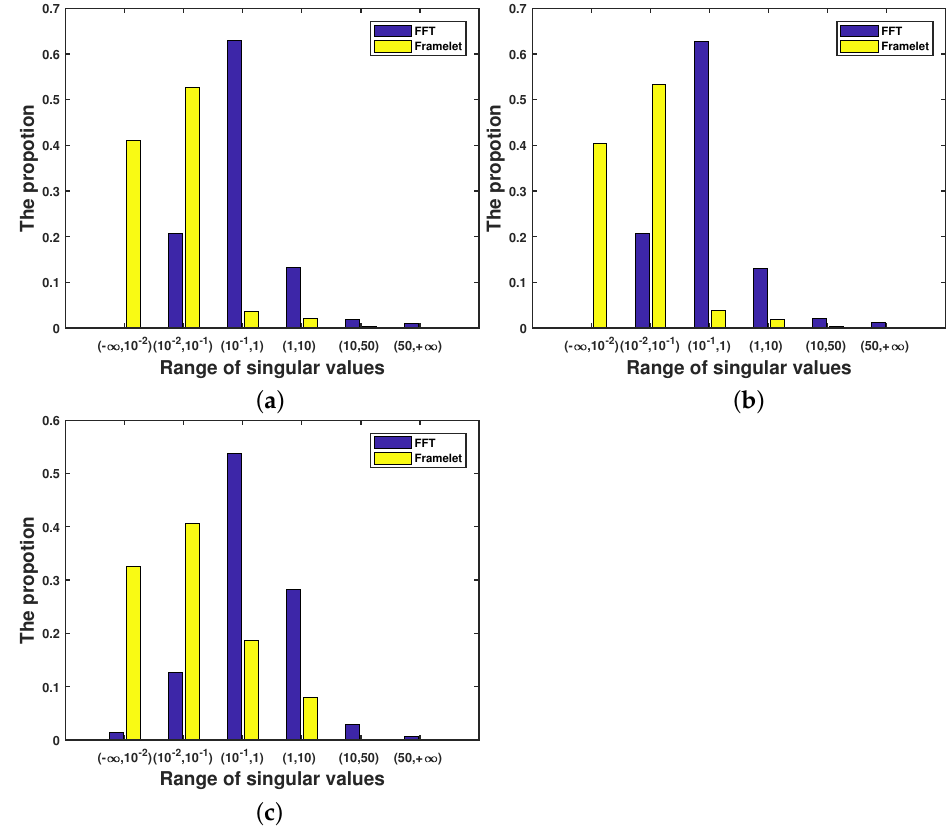
Figure 1. The distribution of singular values on each frontal slice of the two different transformed tensors. ( a ) The first mode, ( b ) the second mode, ( c ) the third